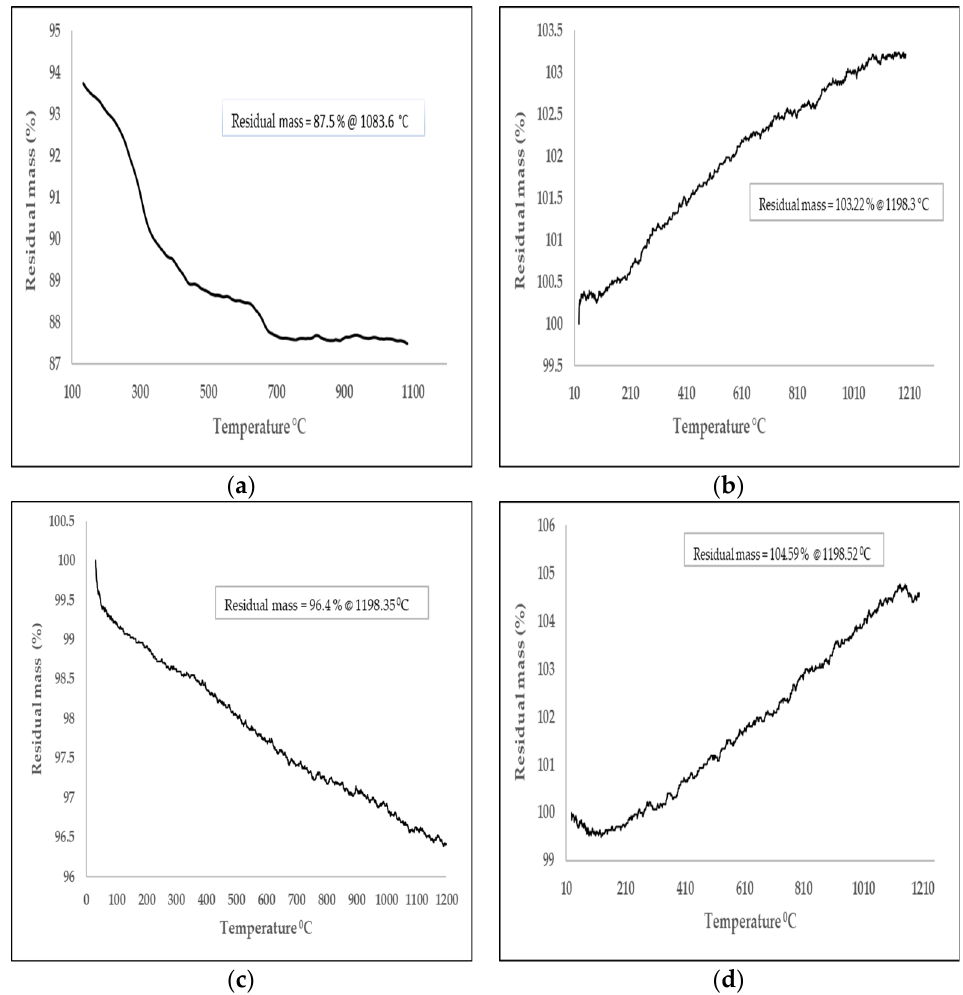
Figure 7. ( a ) Thermogravimetric analysis of red mud sample. ( b ) Thermogravimetric analysis of fly ash sample. ( c ) Thermogravimetric analysis of ground granulated blast furnace slag sample. ( d ) Thermogravimetric analysis of alccofine sample.